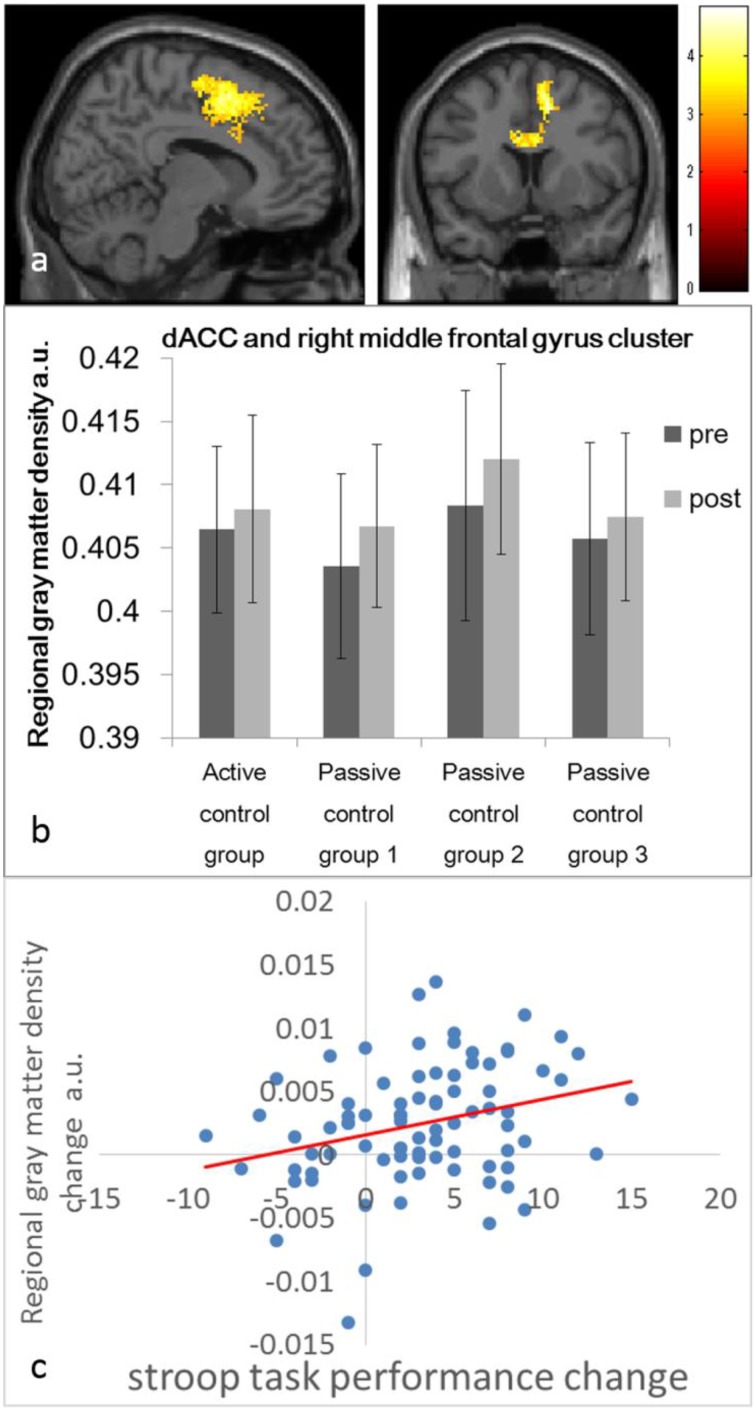
Regional gray matter density (rGMD) increases and their association with improvement in the performance of cognitive tests in the control groups. (A) rGMD increase in the control groups. Results are shown with P < 0.05 corrected for multiple comparisons at the non-isotropic adjusted cluster level with an underlying voxel level of P < 0.0025 (uncorrected). (B) The histogram presents the mean rGMD values of the significant cluster that spread around the bilateral dorsal anterior cingulate cortices and the right superior frontal gyrus before and after the intervention period for each control group. Error bars represent standard deviations. (C) A scatter plot between the improvement of Stroop test performance and the mean rGMD value in the significant cluster in (A) is presented for visualization only.